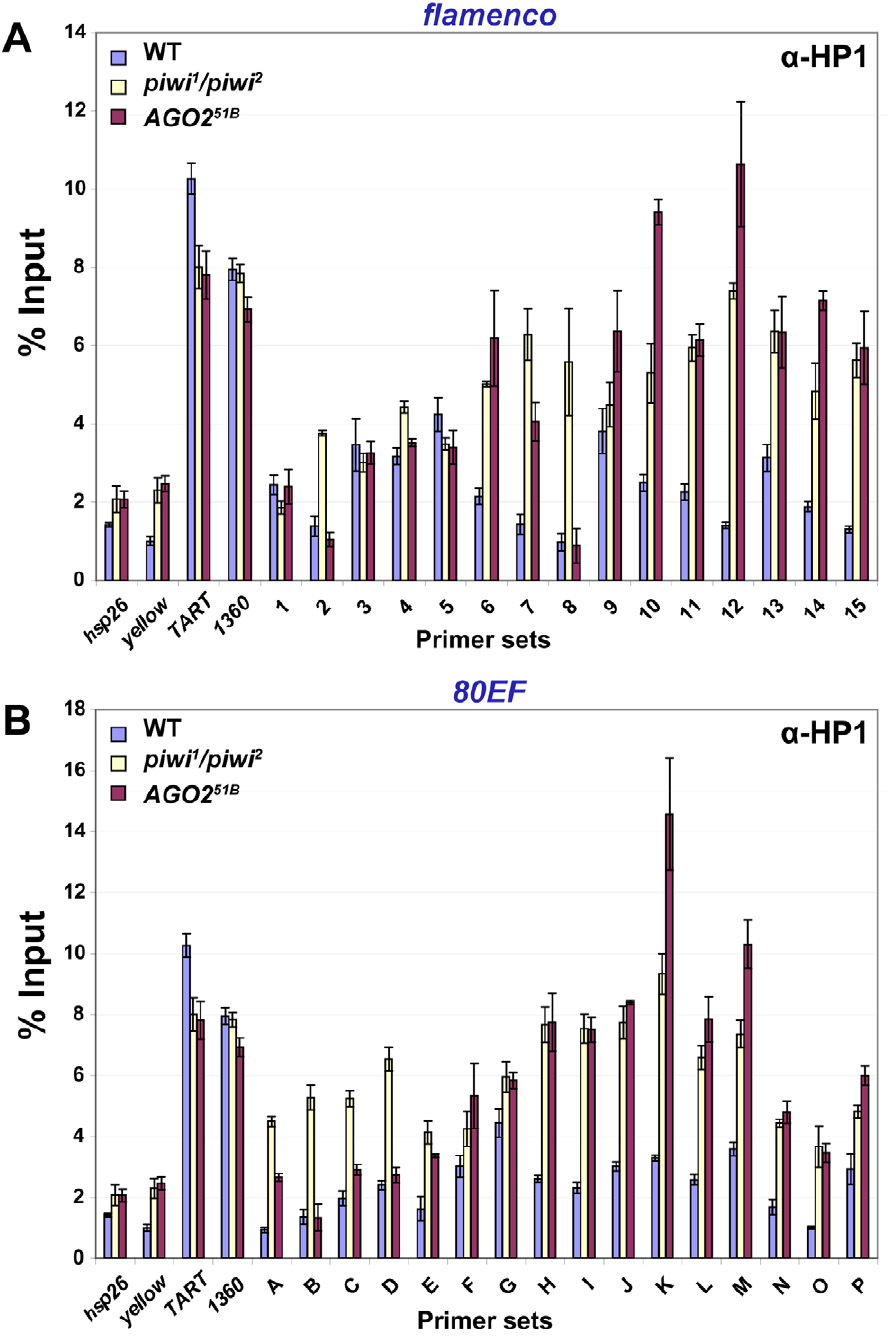
Figure 3. HP1 associates with chromatin at piRNA clusters, and its levels increase in RNA–silencing mutants. ChIP at (A) flam and (B) 80EF piRNA clusters in wild type (blue), piwi 1 /piwi 2 (yellow), and AGO2 51B (red) mutants from adult heads with antibodies specific to HP1. Percent input immunoprecipitated is shown for each primer set, and error bars indicate standard deviation of quadruplicate PCR measurements.